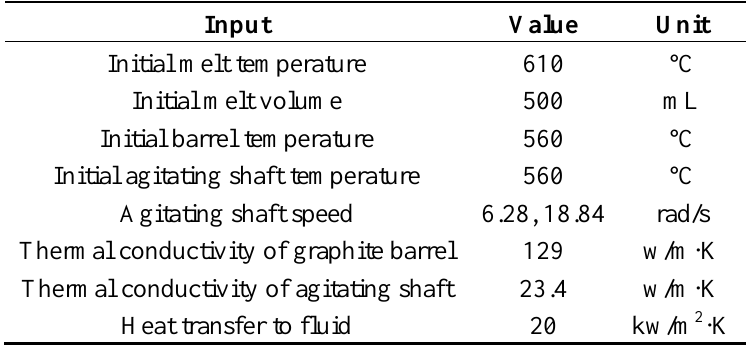
Table 2. Process and initial conditions of